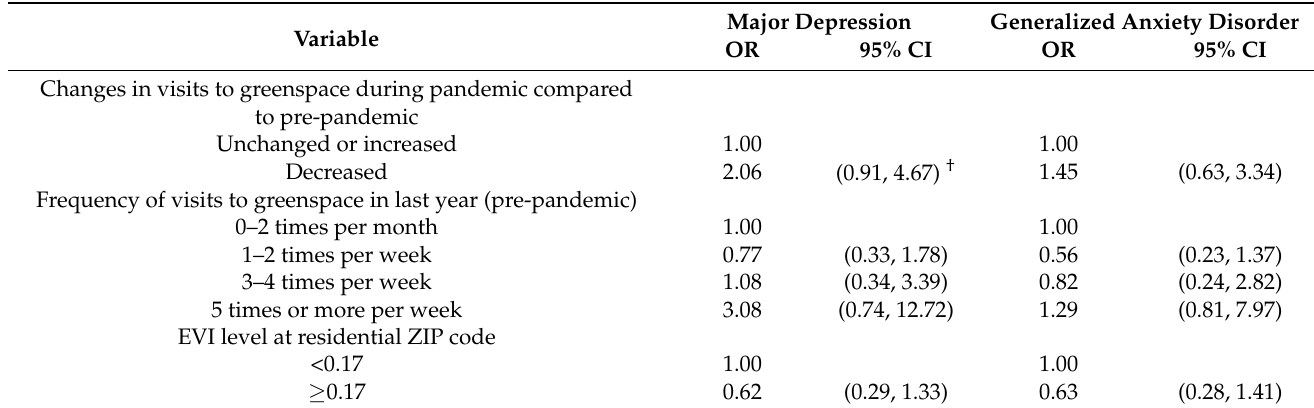
Table 2. Results of multivariable regression analysis: Odds ratio (OR) of major depression and generalized anxiety disorder in relation to changes in visits to greenspace during the pandemic compared to pre-pandemic period, frequency of visits to greenspace in pre-pandemic period, and ZIP-code-level greenness level